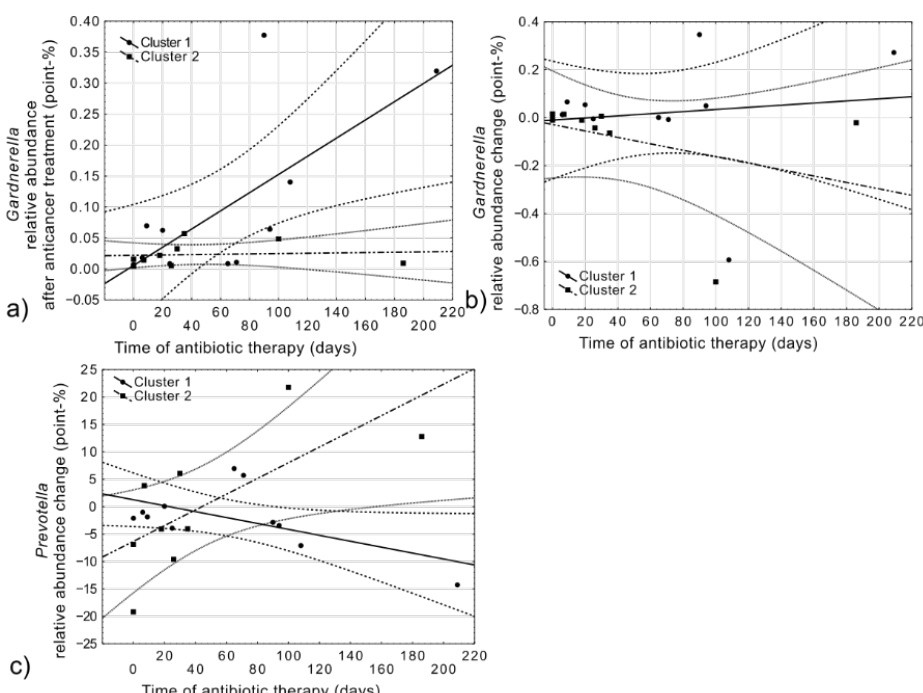
Figure 5. Clinical diversity of identified clusters: ( a ) difference in the age at diagnosis of patients from Cluster 1 and Cluster 2; p = 0.0049. ( b ) Difference in the length of anti-cancer therapy be- tween patients from Cluster 1 and Cluster 2; p = 0.0038.